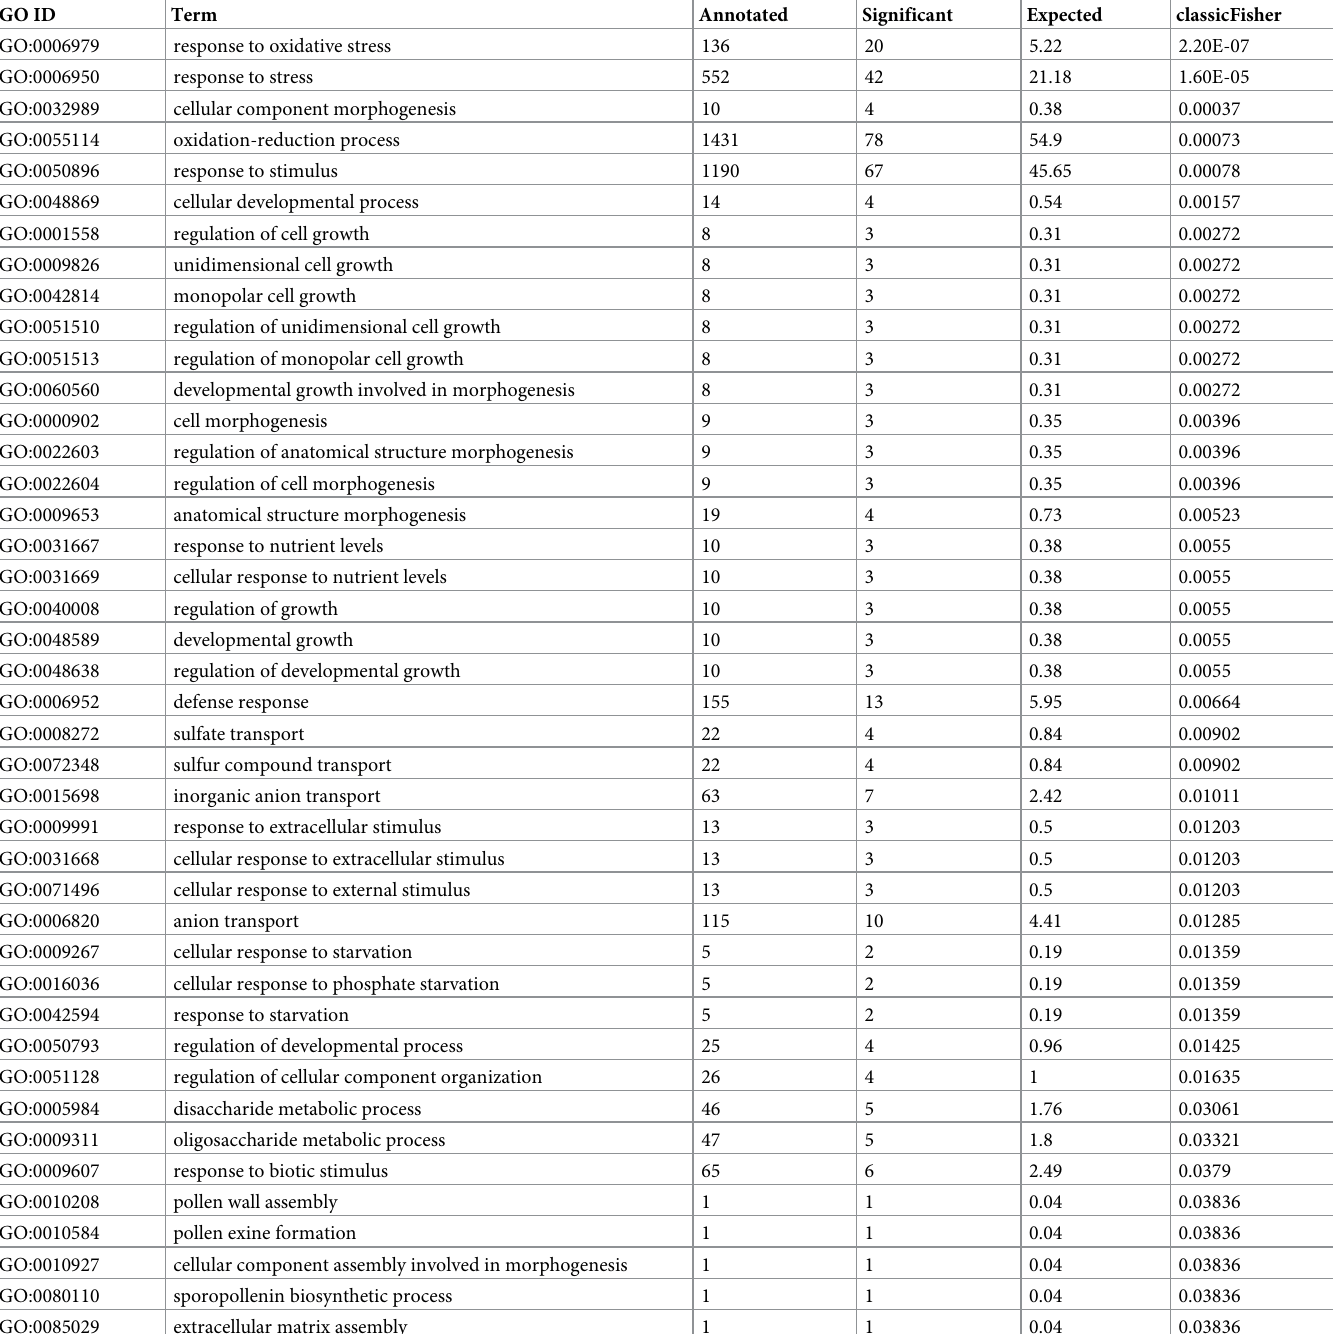
Table 2. Gene Ontology enrichment for the significantly downregulated co-expressed mRNAs of the neighboring